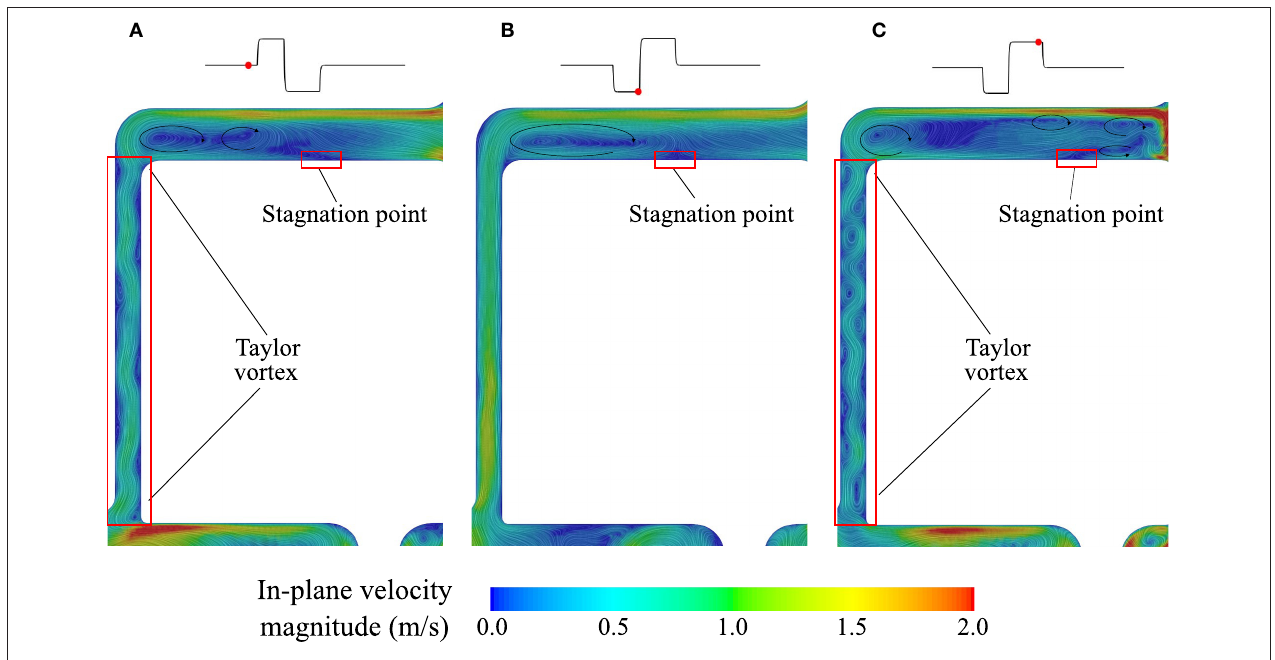
FIGURE 7 | Velocity field in the secondary flow path. (A) Baseline, (B) Low-speed phase of the AP, and (C) High-speed phase of the